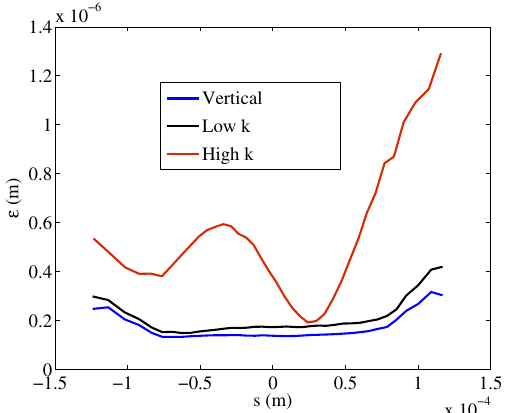
FIG. 17. Measured horizontal slice emittance (top) and mismatch with respect to the core (bottom) along the bunch. The compression factor is fixed to 8. The measurements with compressed beam are repetitions under the same conditions, performed to assess the reproducibility of the result.